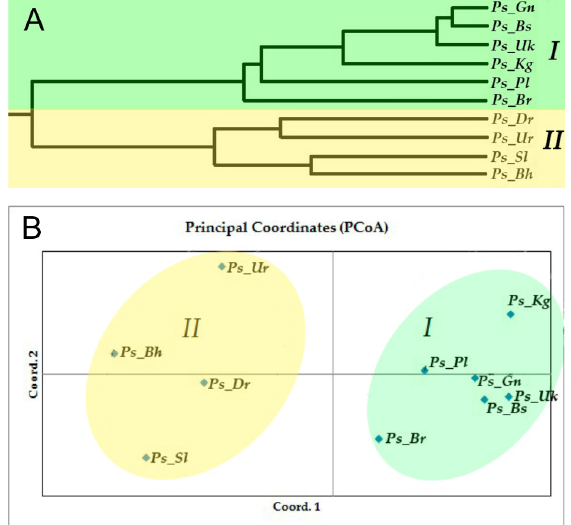
Figure 3. ( A ) Dendrogram of genetic similarity of ten studied populations of P. sylvestris, built on the basis of polymorphism of ISSR profiles by unweighted pair-group method (UPGMA); Ps_Br